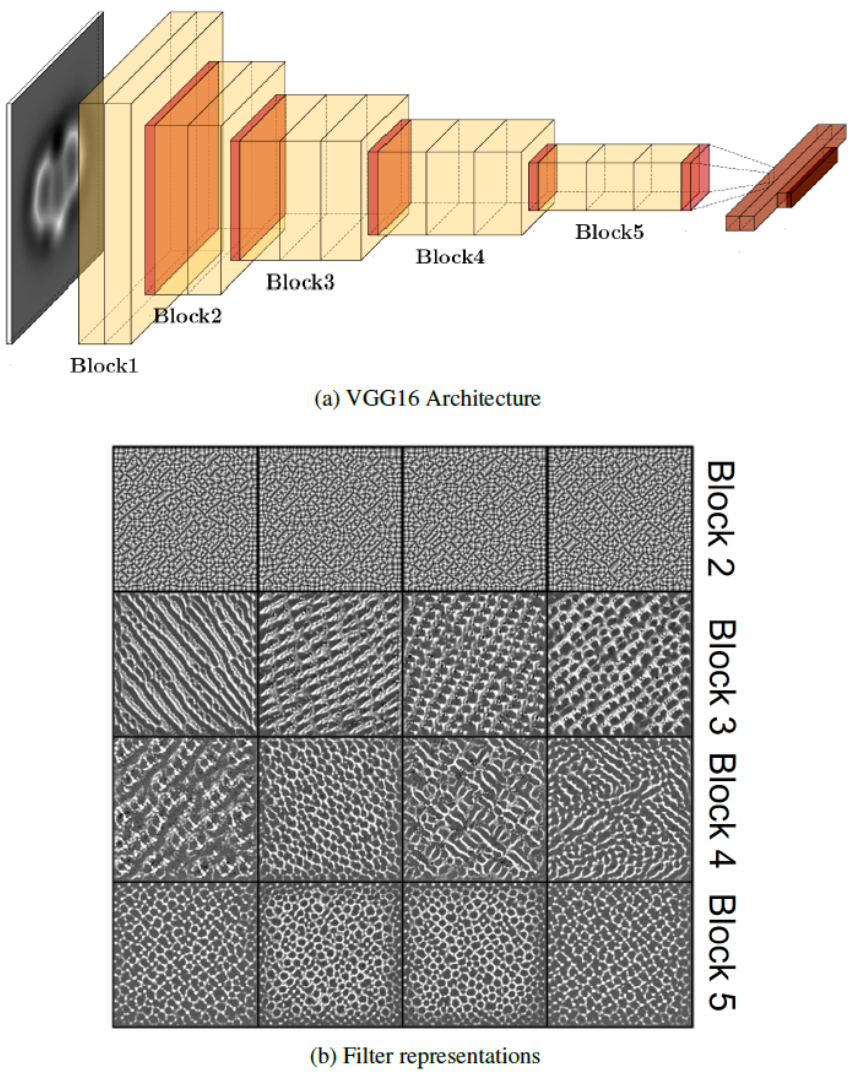
Figure 4. ( a ) The VGG16 architecture combines five blocks, each composed by a series of convolution (yellow), pool (red), flatten (purple), and fully connected (brown) layers, in order to reduce the initial input, a 224 × 224 image, into a probability vector with the size of the number of different classes (see ref. [46] for a definition of these layers). ( b ) Representations of the filter patterns learned by some of the convolutional layers of the VGG16 model during the training with SPMTH-60 dataset. From top to bottom, each row includes four filters located in the last convolutional layer of blocks 2, 3, 4, 5, respectively. Although the patterns in blocks 4 and 5 show specific features in the AFM images such as ring deformations, those on block 3 display non-specific features that are usually learned in the first layers of the model. Only random patterns can be observed in the last layer of block 2. Since the filters are modified by applying back propagation, none of the filters belonging to the first two blocks have been updated during the training, a clear indication that the model is in